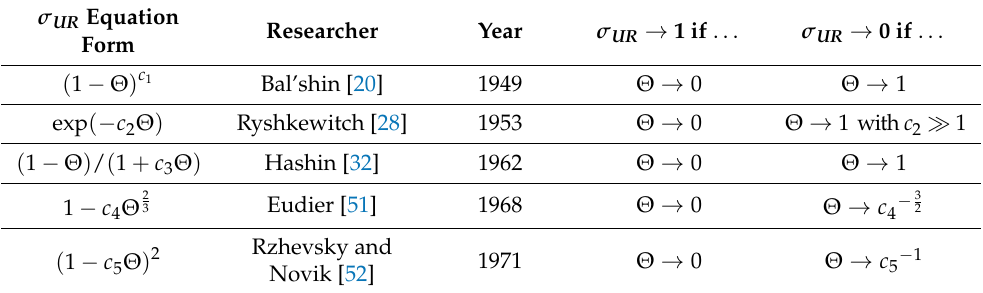
Summary of relationships for the relative ultimate strength of porous